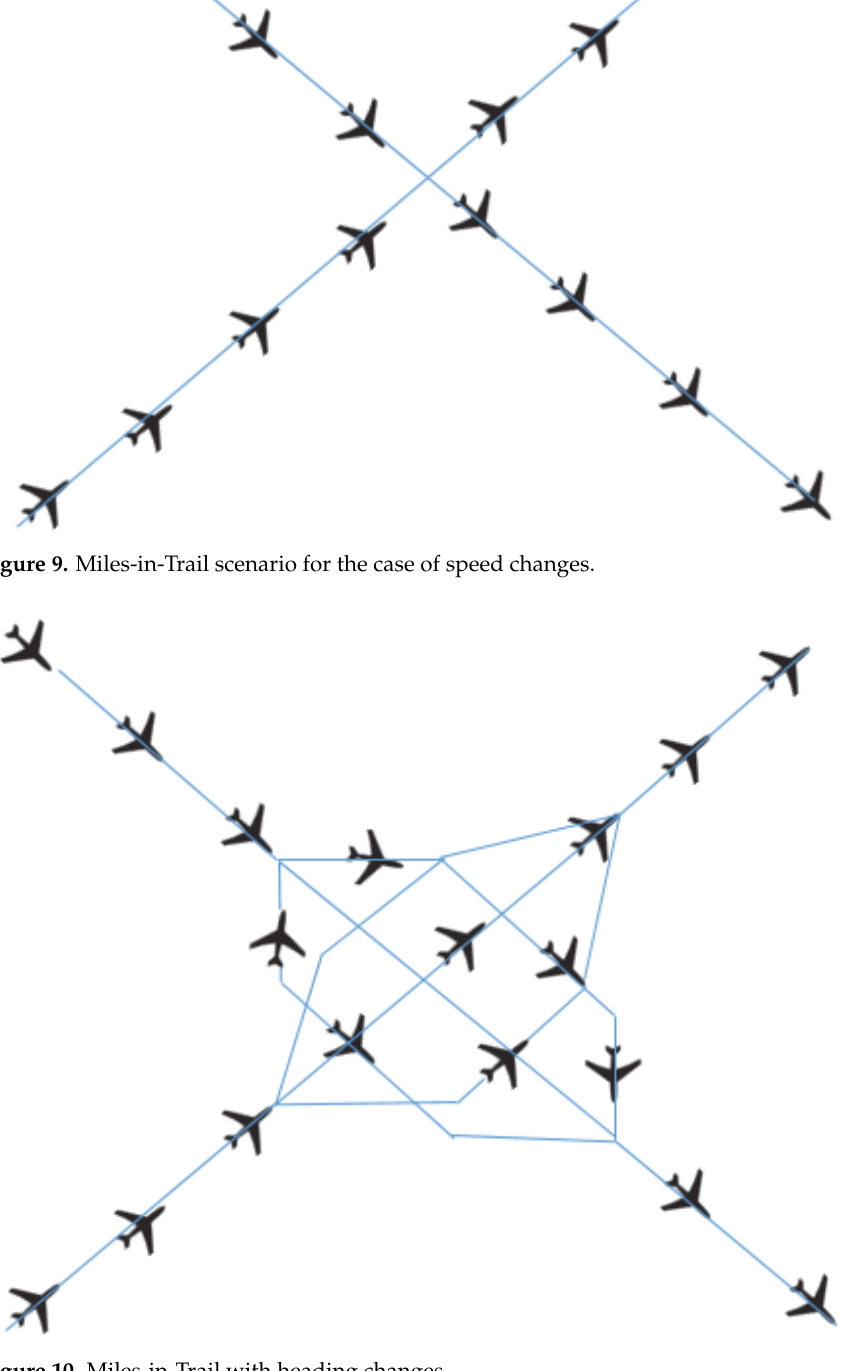
Figure 10. Miles-in-Trail with heading